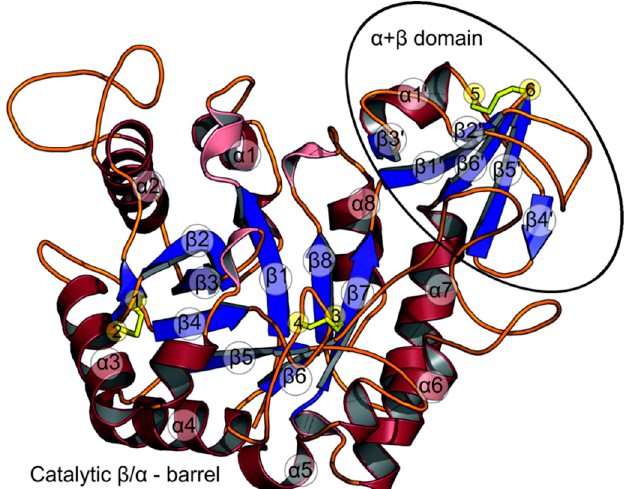
Figure 2. Cartoon plot of St Chi40. The two protein domains are labelled. The secondary structure elements— α -helices (red), β -sheets (blue), 3 10 -helices (pink)—of the catalytic domain are labelled according to the convention for β / α -barrels. The α + β insertion domain is marked by an oval. Cysteine residues forming disulfide bridges are labelled (yellow sticks) and numbered: 1—Cys86, 2—Cys162, 3—Cys188, 4—Cys192, 5—Cys343, 6 — Cys357.